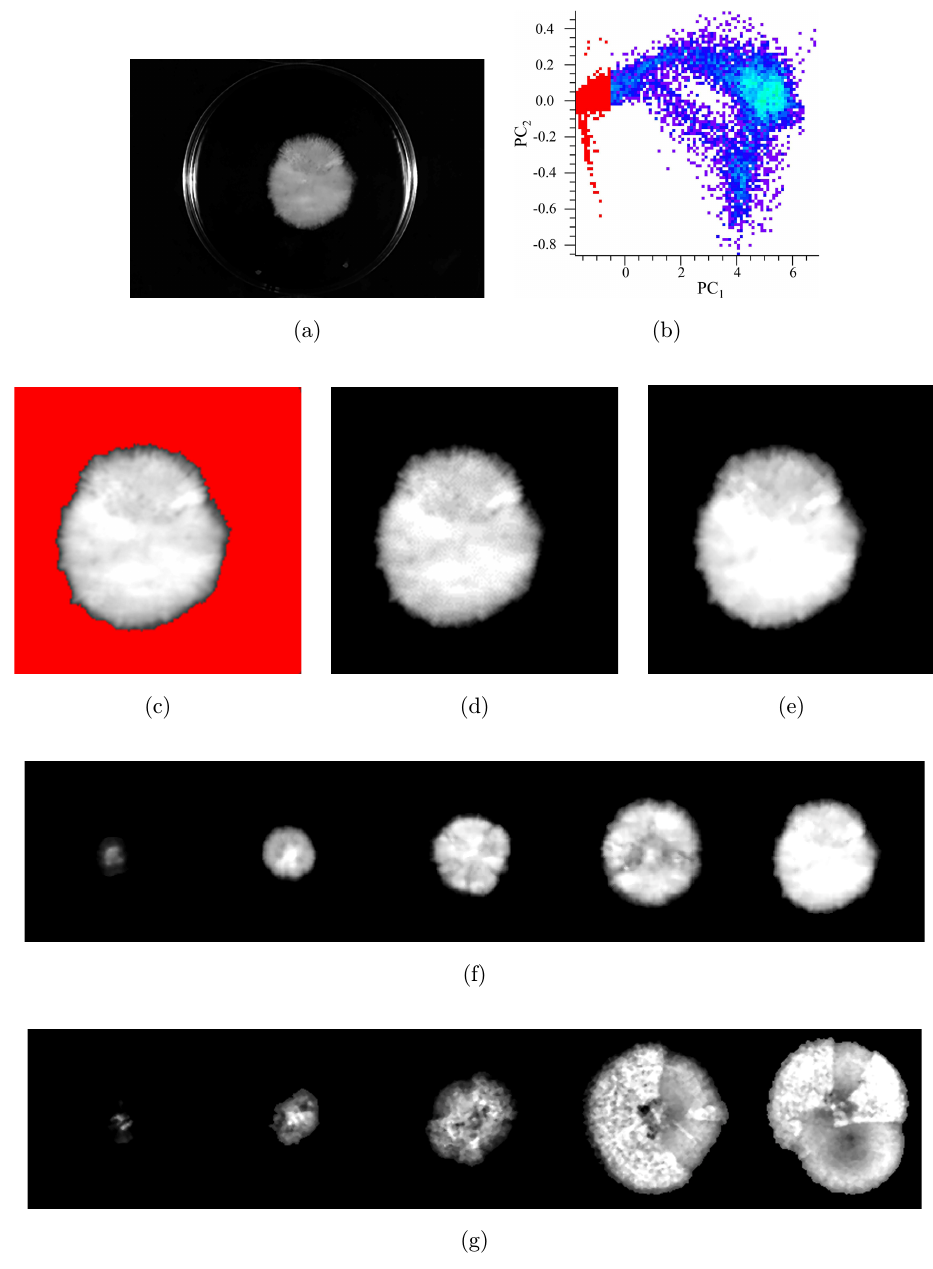
Fig. 2. An illustration of hyperspectral images preprocessing. (a) Gray image of colony incubated on RBM. (b) Score plot of PC 1 against PC 2 . (c) Corresponding pixels of background. (d) Extracted colony. (e) Corrected colony image. (f) Colonies growing on RBM. (g) Colonies growing on